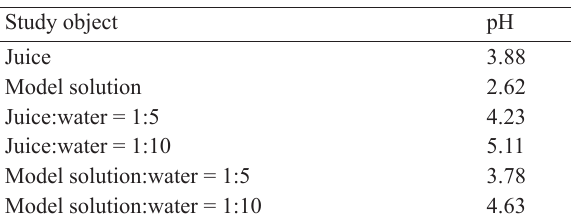
Table 1 pH of study objects Study object